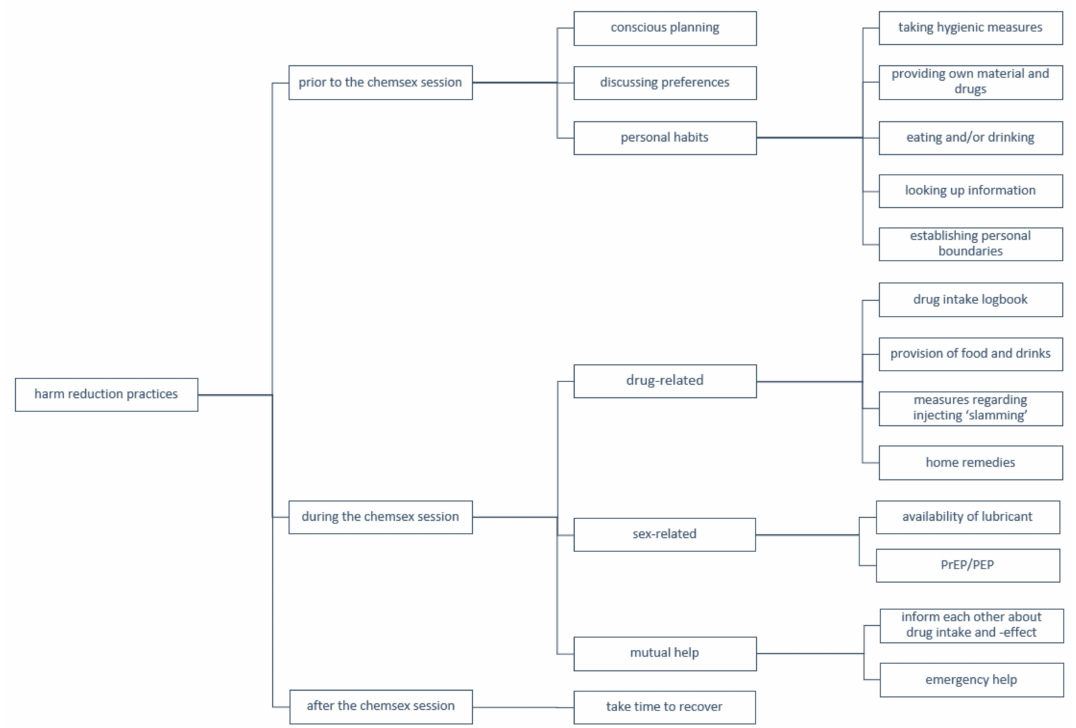
Figure 1. Schematic overview of harm reduction